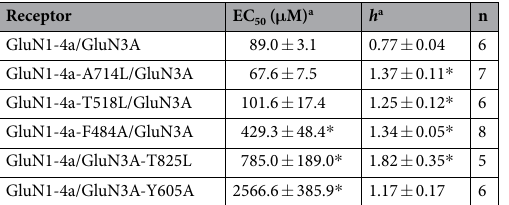
Table 1. Summary of the fitting parameters for the peak concentration-response relationship measured for wild-type and mutant GluN1/GluN3A receptors expressed in HEK293 cells (see Figs 2g and 3g). a The EC 50 values and Hill coefficient (h) were obtained by fitting the normalized data from each cell using Equation (1). Data are presented as the mean ± SEM, and n corresponds to the number of cells recorded. Statistical analysis was performed for logEC 50 and logHill values; * p < 0.05 vs. GluN1-4a/GluN3A (one-way ANOVA with post- hoc Dunnett’s